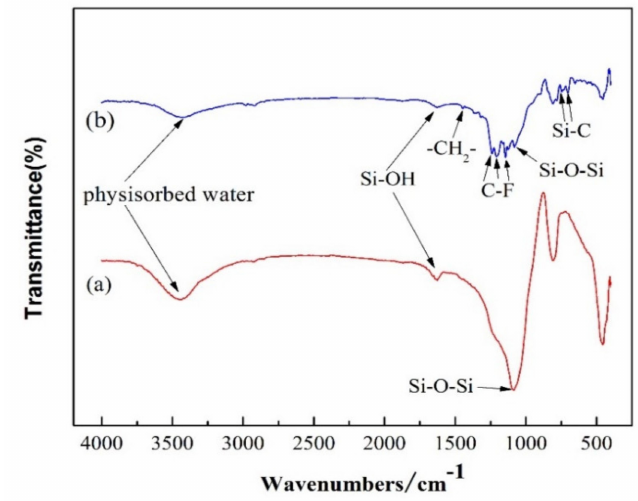
Figure 5. Fourier transform infrared (FT-IR) spectra of the samples: ( a ) pristine silica membrane; ( b ) PFOTES-SiO 2